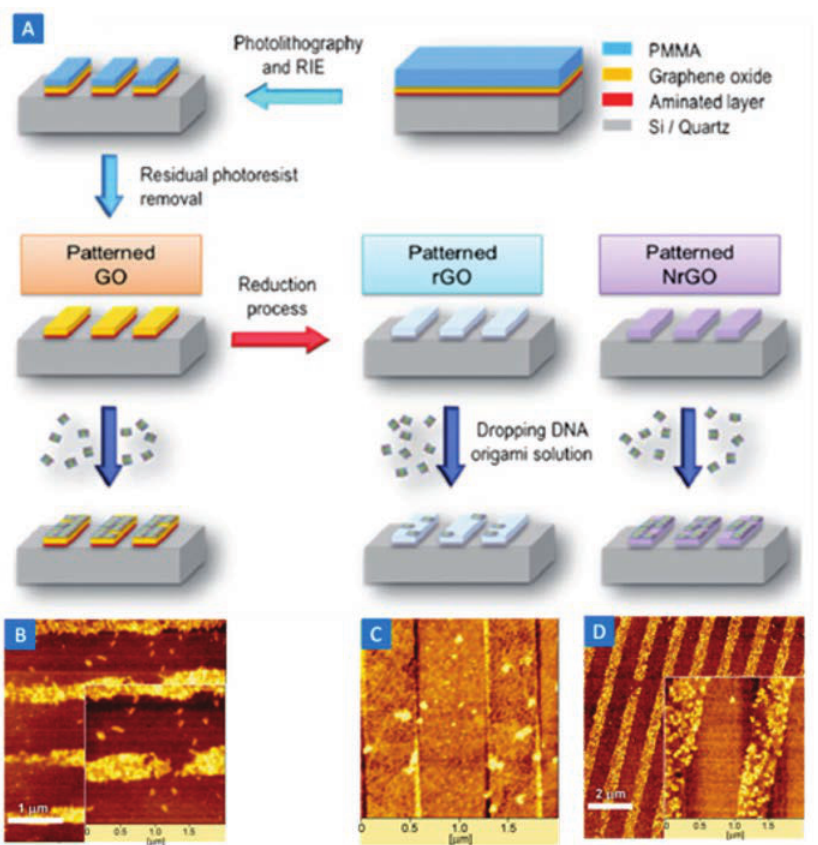
Figure 11. (A) Patterning of DNA origami structures on graphene-based substrates. Spin-cast GO films are lithographically patterned and chemically modified by reduction or N doping. DNA origami structures were assembled on patterned graphene-based films from buffer solution (RIE=reactive ion etching). AFM images of DNA origami structures assembled on the patterned B) GO, C) rGO, and D) NrGO, respectively. Reprinted with permission from [60 ]. Copyright 2011 WILEY-VCH [